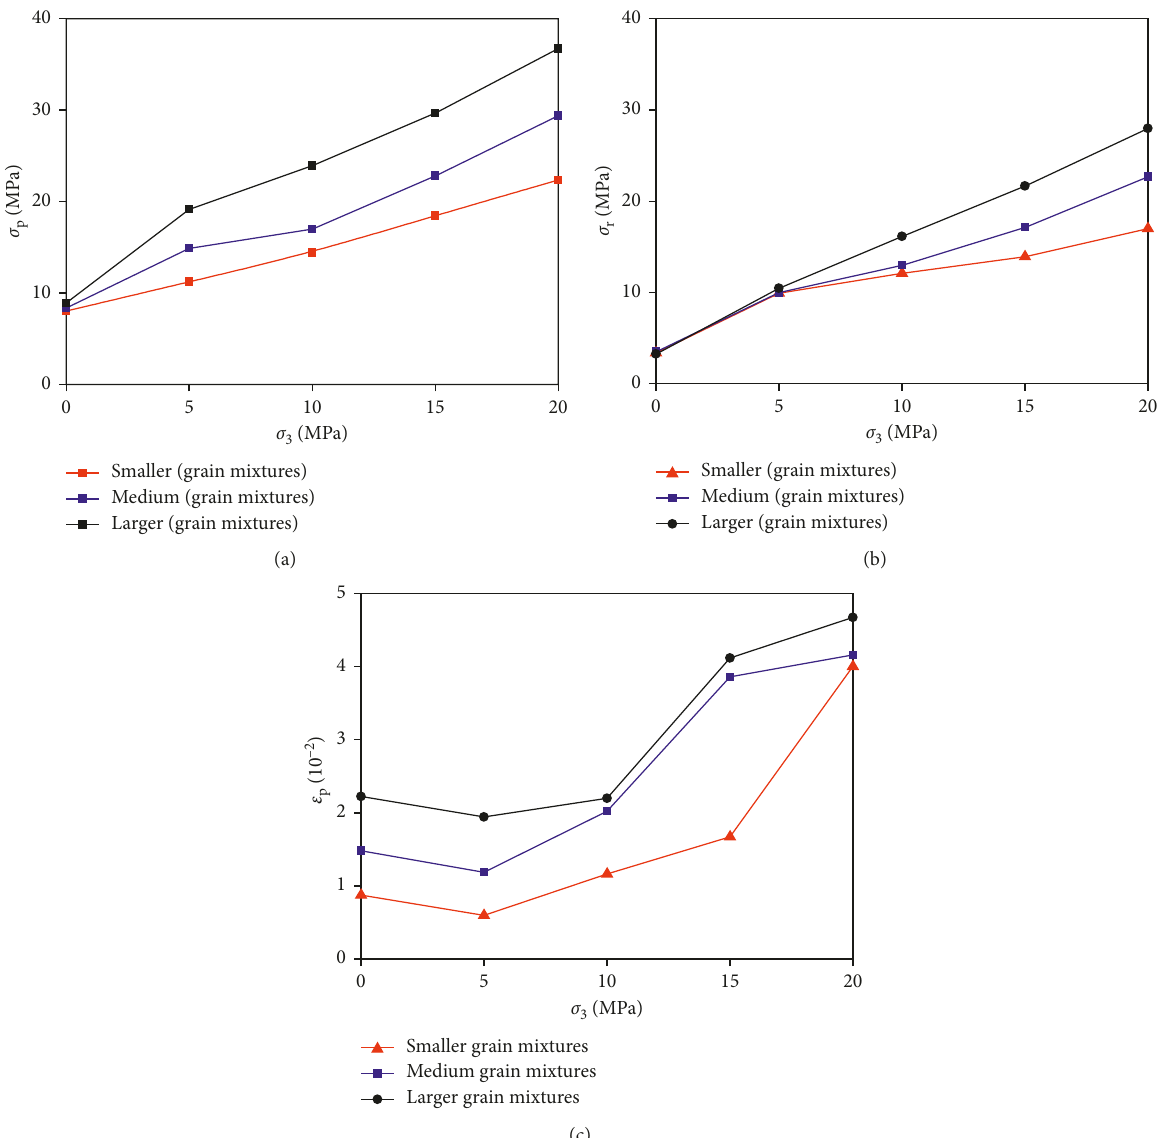
Figure 8: (a) Average values of peak strengths, (b) average values of residual strengths, and (c) average values of peak strains of grouted specimens with different grain size mixtures versus confining pressures. Table 3: The average slope values of the σ Grain size